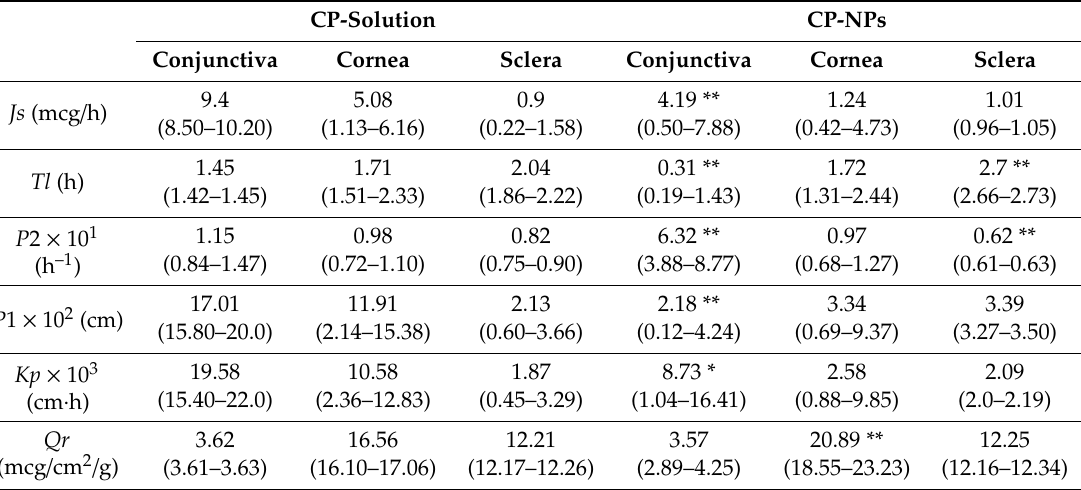
Table 2. Median, maximum and minimum values of flux ( Js ), lag time ( Tl ), P1, P2, permeability coe ffi cient ( Kp ) and in vivo retained amount ( Qr ) of CP at 6h from the solution of CP (CP-Solution) and nanoparticles of CP (CP-NPs) through ophthalmic membranes (conjunctiva, cornea, sclera).